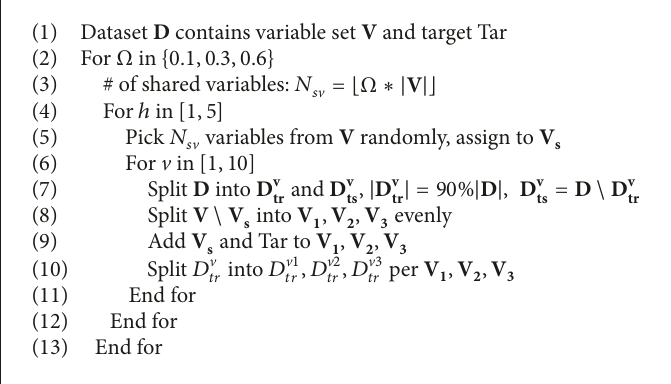
Algorithm 1: Generating original synthetic datasets.